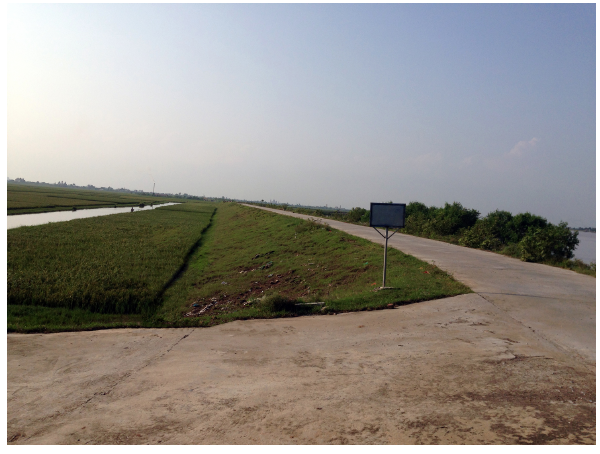
Figure 5. Example of a river dike for flood control in Nam Dinh Province in the Red River